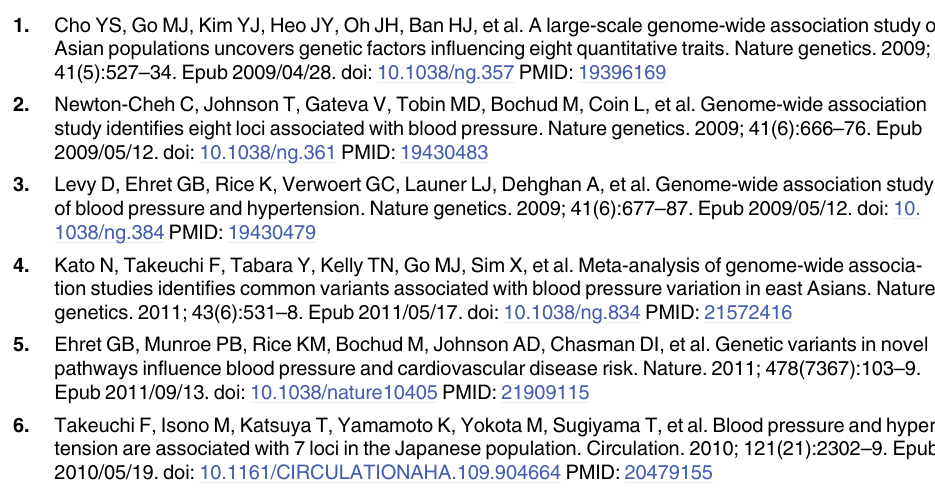
S2 Table. The lead SNP (rs1378942) and variants with r 2 > = 0.2 (European population) (HaploReg v3). S3 Table. The catalog of Published Genome-Wide Association Studies for variants near the